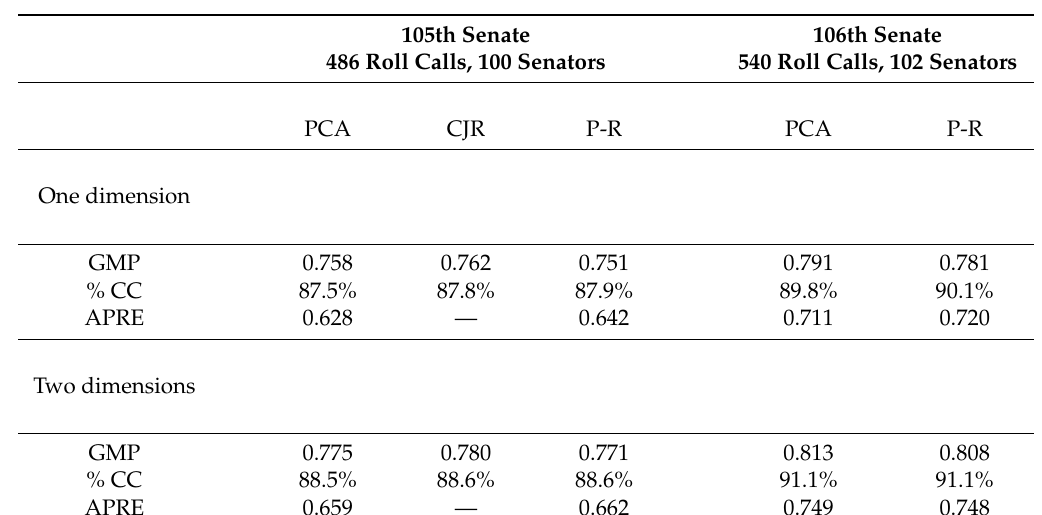
Table 3. Measures of model fit for PCA, CJR, and P-R, for results in one and two dimensions, 105th and 106th